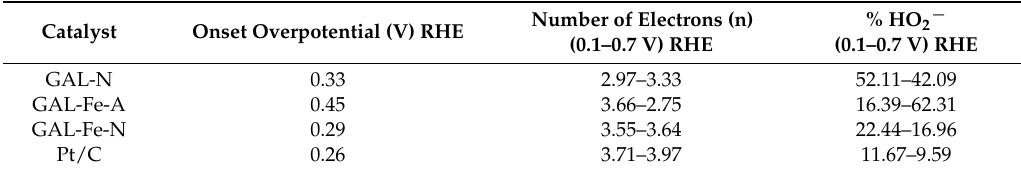
Figure 4. Rotating ring disc voltammograms recorded with GAL-N, GALFe-A, GALFe-N and Pt/C electrodes. ( A ) Ring current; ( B ) disc current; ( C ) HO 2 − peroxide produced (%) against applied potential; and ( D ) number of total electrons transfers against applied potential. Table 1. Electrochemical properties of catalysts.